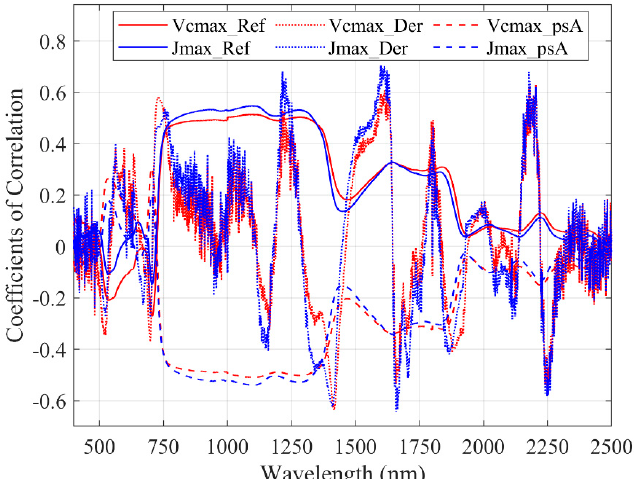
Figure 6. Correlation test between photosynthetic capacity and wavelength. The su ffi x ‘Der’ refers to the first-order derivative spectra, while the ‘Ref’ for the original reflectance, and the ‘psA’ for the apparent absorption